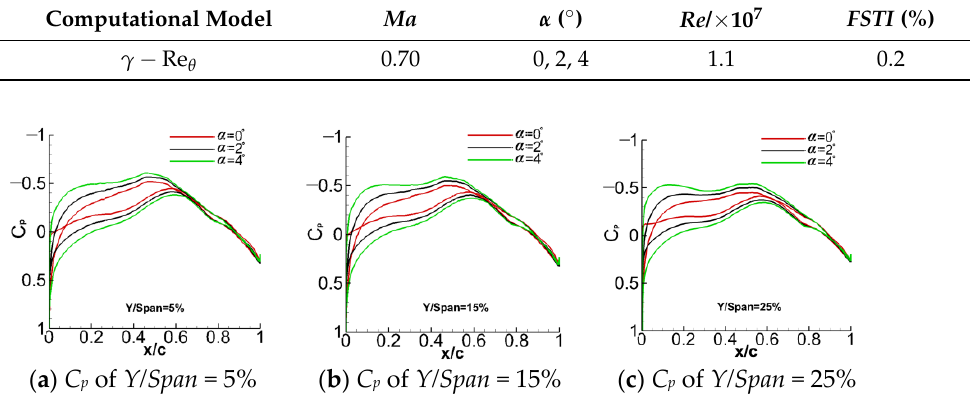
Table 6. Calculated states and method for different α .